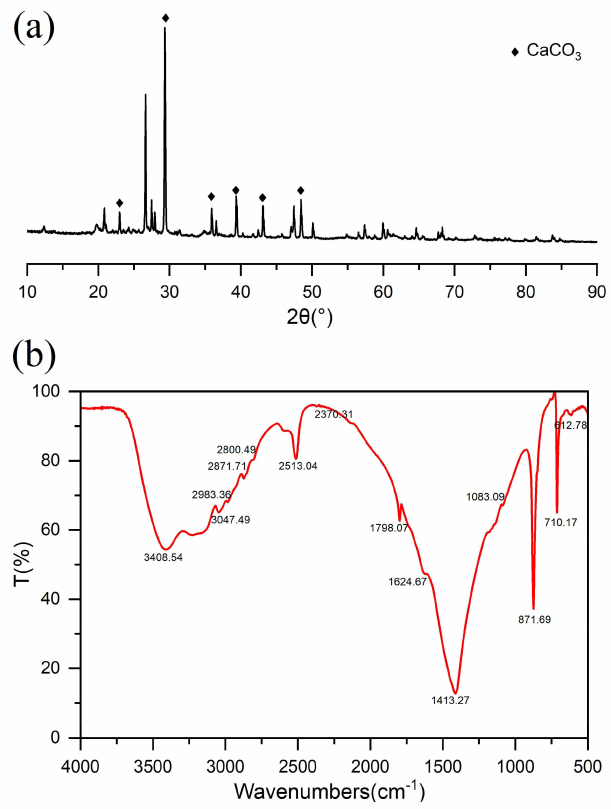
Figure 15. Physical property analysis of cement: ( a ) XRD pattern; ( b ) FT-IR spectrum of